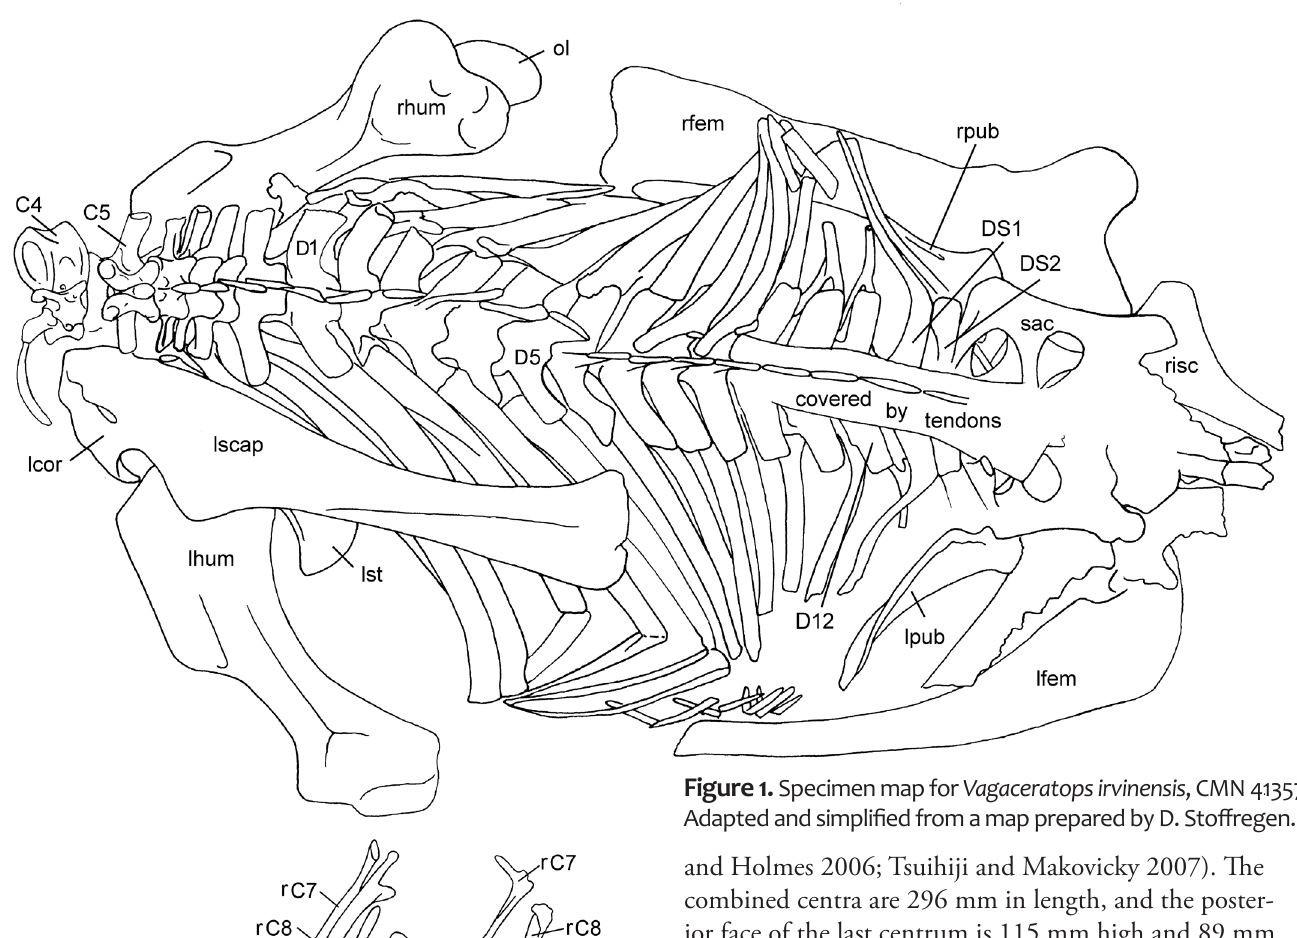
Figure 1. Specimen map for Vagaceratops irvinensis , CMN 41357. Adapted and simplified from a map prepared by D. Stoffregen.